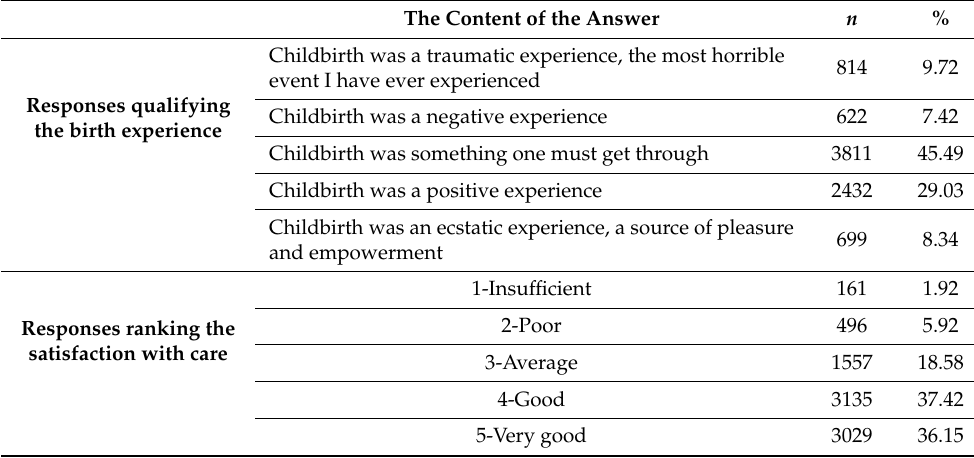
Table 2. Distribution of answers corresponding to expressions responses qualifying the birth experience and ranking the satisfaction with care ( n =